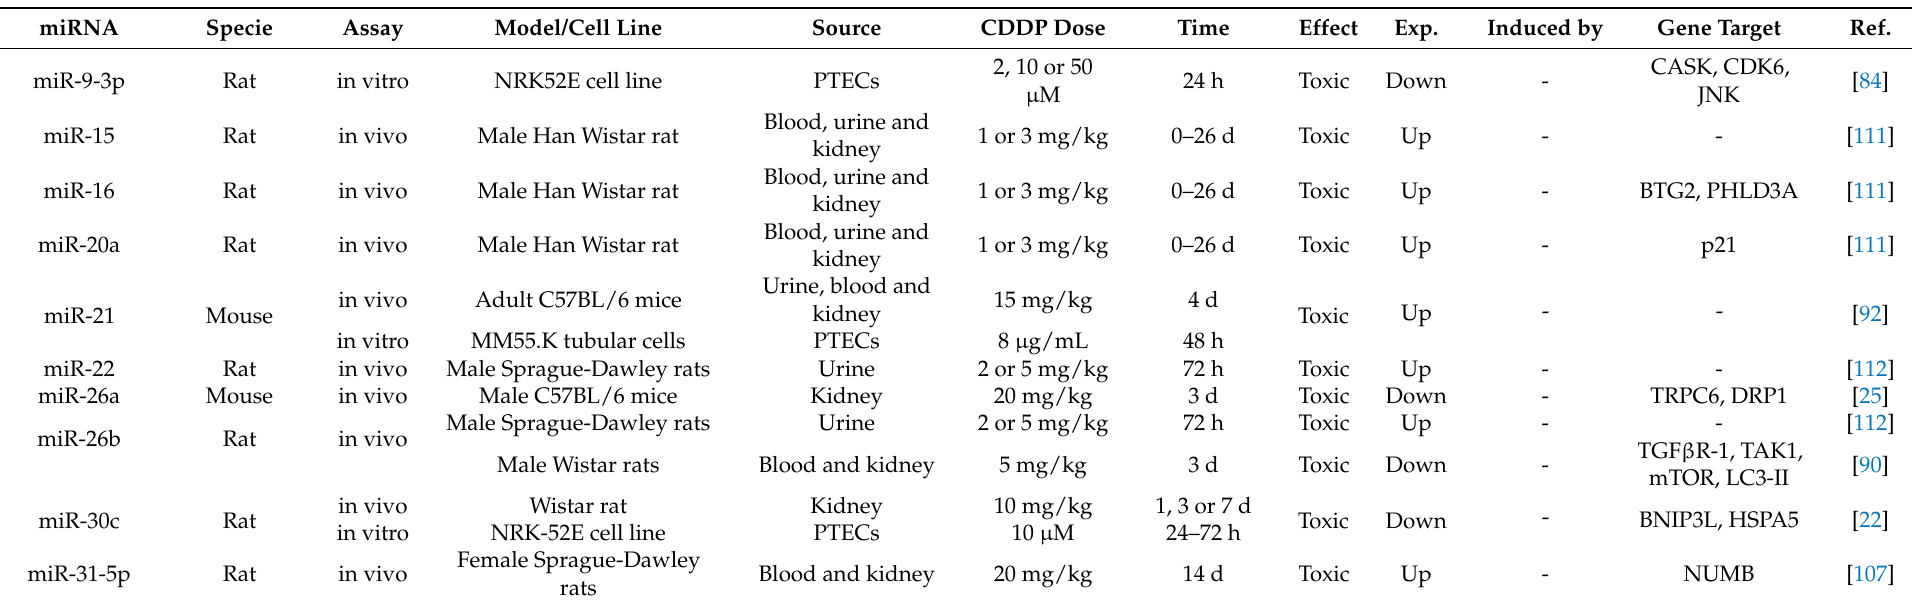
Table 2. In vitro and in vivo evidence of microRNAs involved in cisplatin-induced nephrotoxicity in